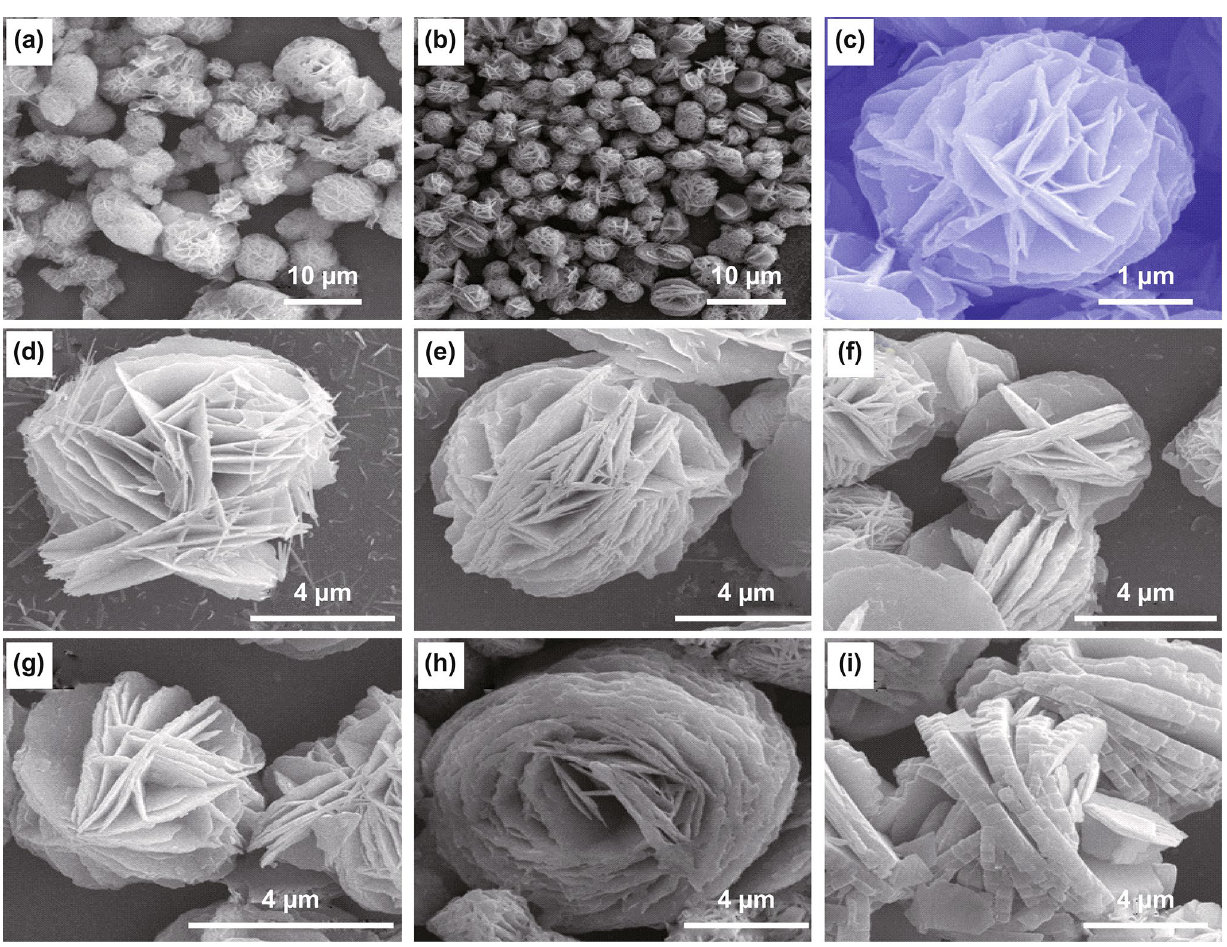
Fig. 20 FESEM images of bimetal Ni-Co-precursors obtained under various microwave-assisted hydrothermal reaction times. a 5 min, b, c 10 min, d 15 min, e 20 min, f 25 min, g 30 min, h 35 min, and i 40 min. Reproduced with permission from Ref. [103]. Copyright © 2019 Else- vier